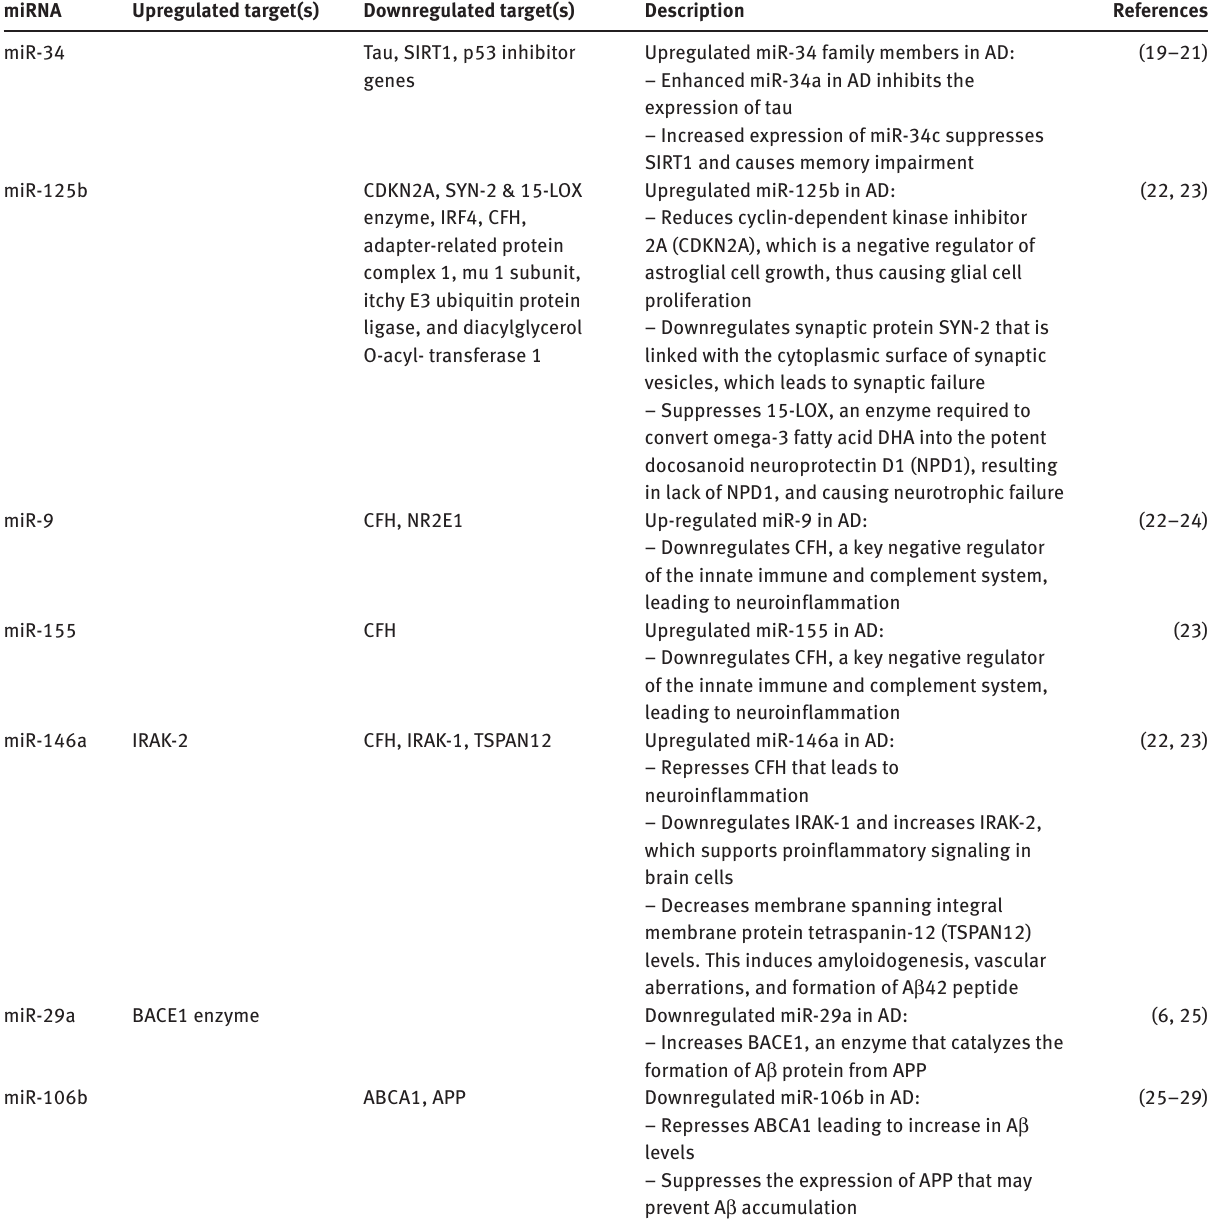
Table 1 : Summary on mRNA targets of AD-associated miRNAs.